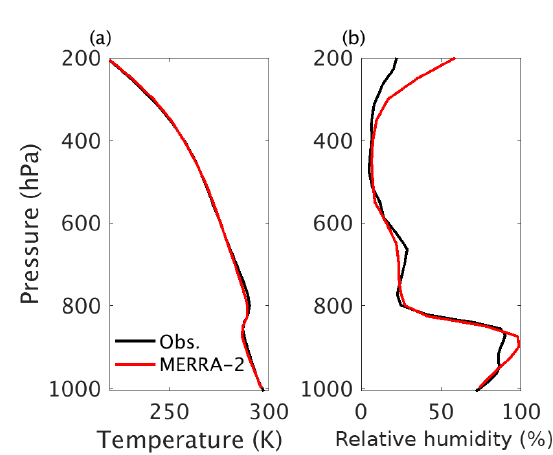
Figure 5. Average (a) temperature and (b) relative humidity pro- files over Ascension Island from INTERPSONDE observations and MERRA-2 during the month of August